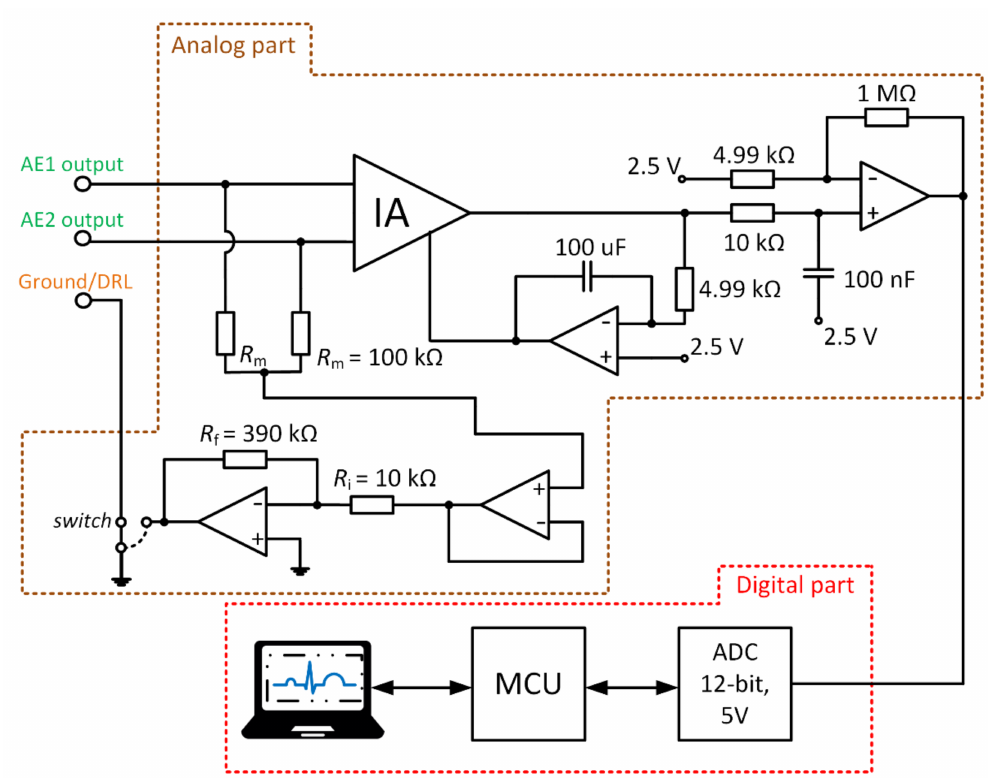
Figure 11. Block scheme of developed electrocardiography (ECG) system.